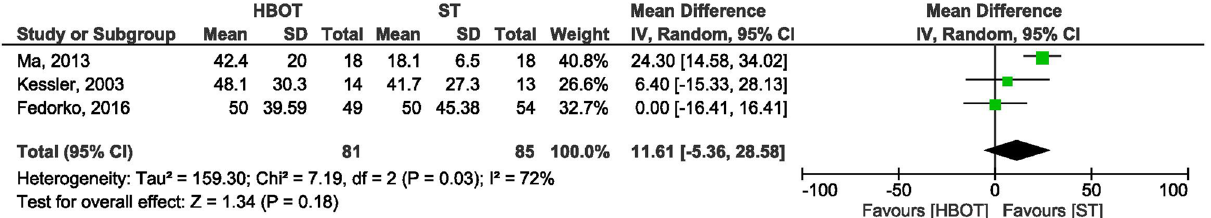
Figure 10. Forest plot of comparison: HBOT versus ST, Outcome: Mean ulcer area reduction (%).